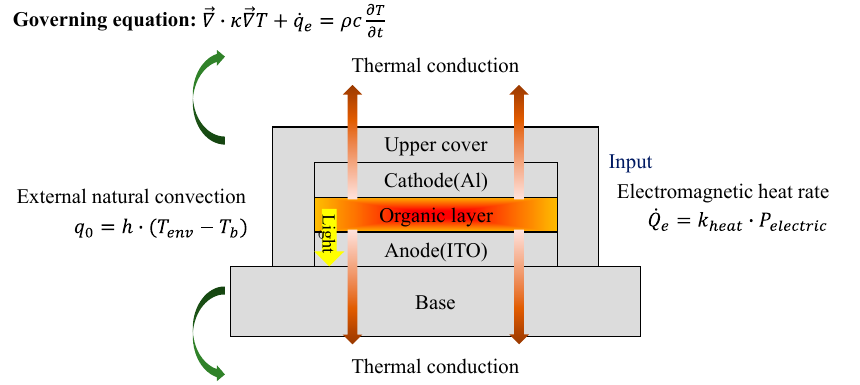
Figure 1. Schematic representation of the electro-thermal simulation model.